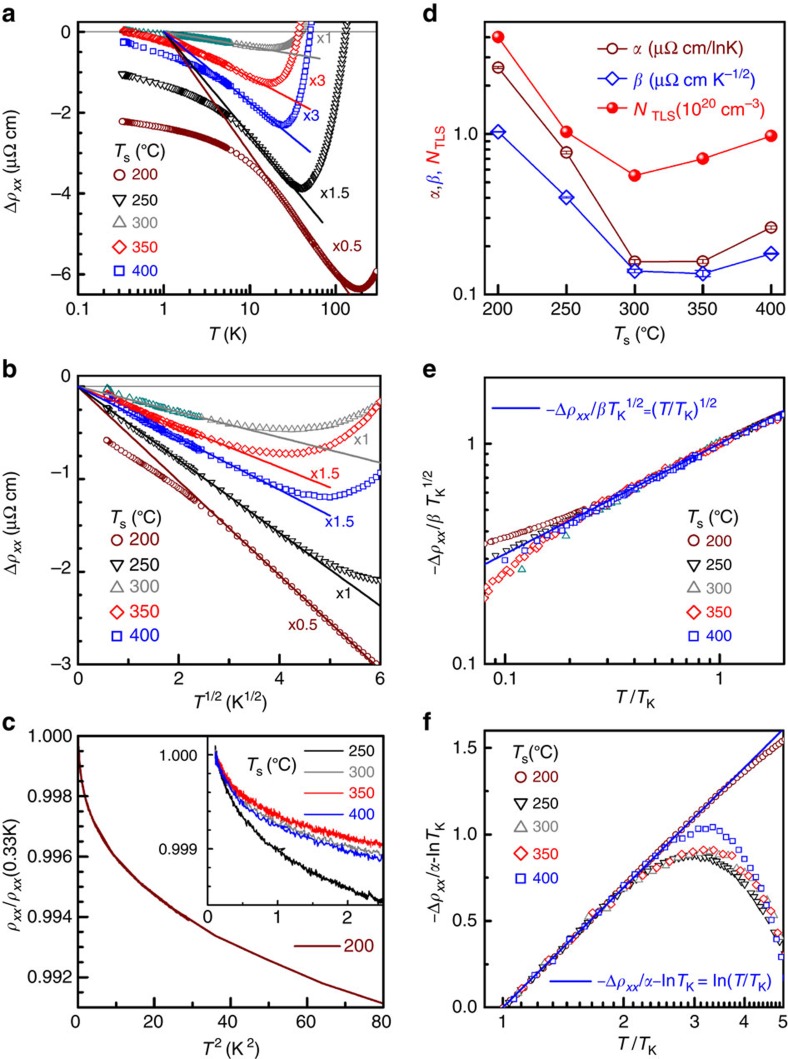
Temperature dependence of zero-field resistivity.(a) Semilog plot of Δρxx versus T, (b) Δρxx versus T1/2, (c) ρxx/ρxx (0.33 K) versus T2, (d) α, β and NTLS versus Ts, (e) log–log plot of −Δρxx/βTK1/2 versus T/TK and (f) semilog plot of −Δρxx/α−lnTK versus T/TK for L10-MnAl films grown at different Ts. For clarity, Δρxx is multiplied by a factor of 0.5 (0.5), 1.5 (1), 1 (1), 3 (1.5) and 3 (1.5) in a (b) for Ts=200, 250, 300, 350 and 400 °C, respectively. (e) and (f) are the scaling plots showing the collapse of the experimental data in the respective temperature regimes; the solid blue lines show the equations −Δρxx/βTK1/2=(T/TK)1/2 and −Δρxx/α-lnTK=ln(T/TK), respectively.